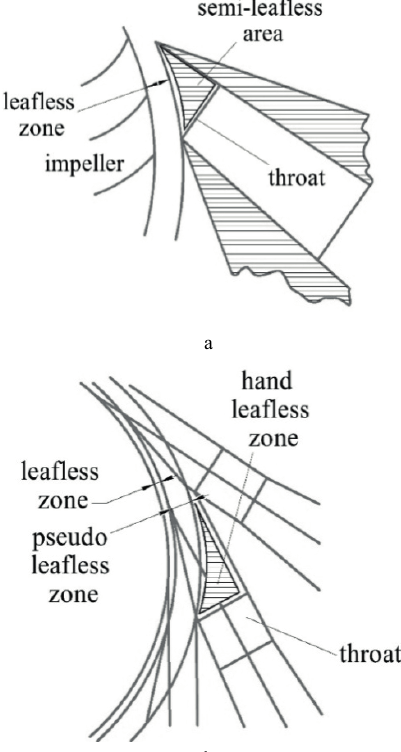
Fig. 1. Schematic diagrams of flow channel structures of vane (a) and vaneless (tube) diffusers